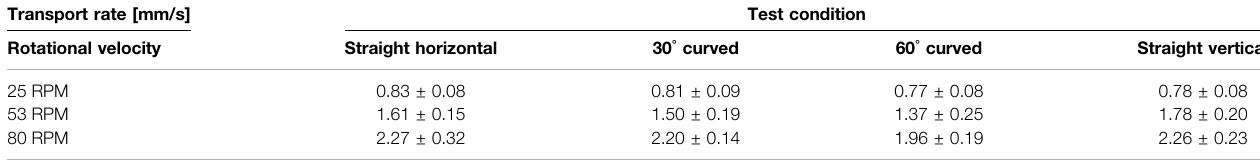
TABLE 1 | Overview of the transport rate [mm/s] of the friction-based transport mechanism for different shaft orientations, curvatures and rotational velocities. Transport rate [mm/s]